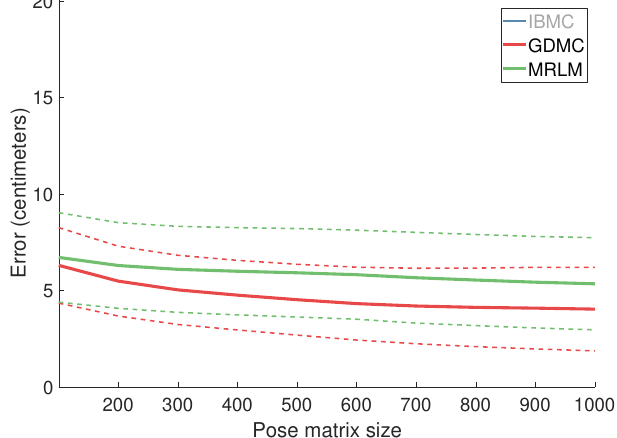
Figure 4. Same as Figure 3 for N = 100 to 1000. GDMC and MRLM level off at 200–300